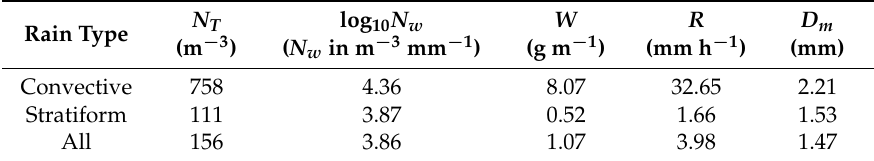
Table 1. Integral physics parameters derived from the composite raindrop spectra for different rain types 1